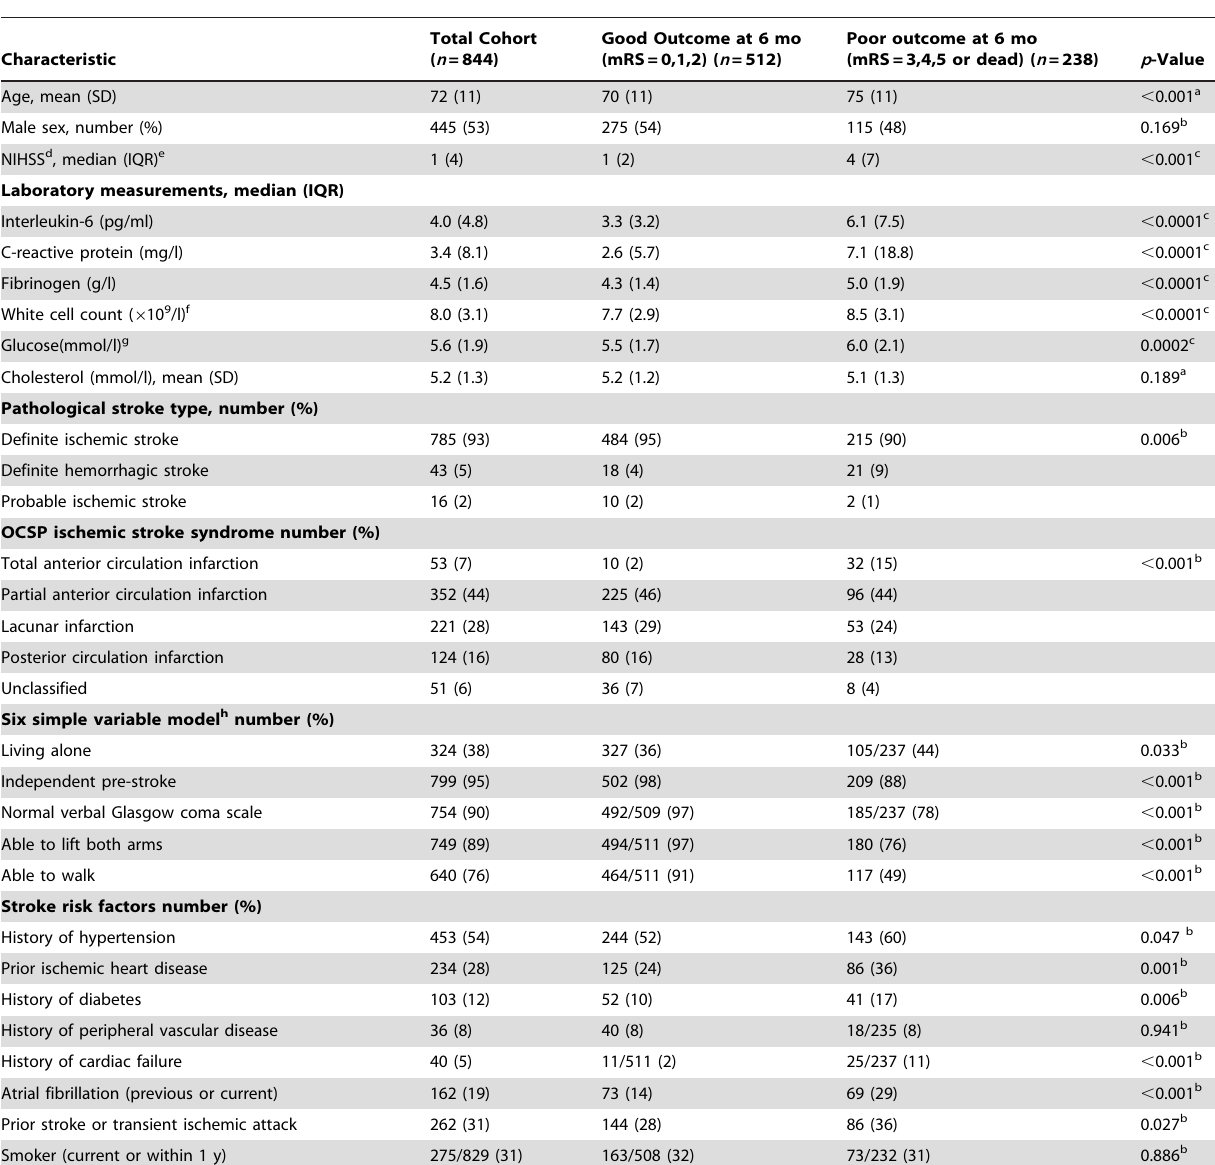
Table 1. Baseline characteristics of biomarker cohort and their association with death and poor outcome.